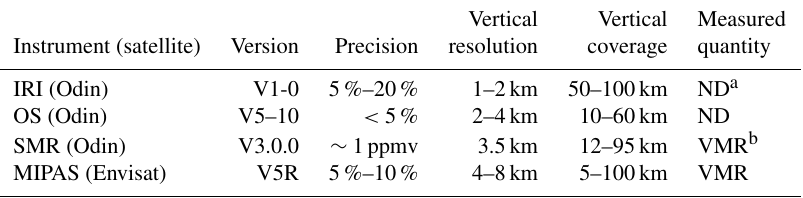
Table 2. Main characteristics of the ozone datasets under consideration.